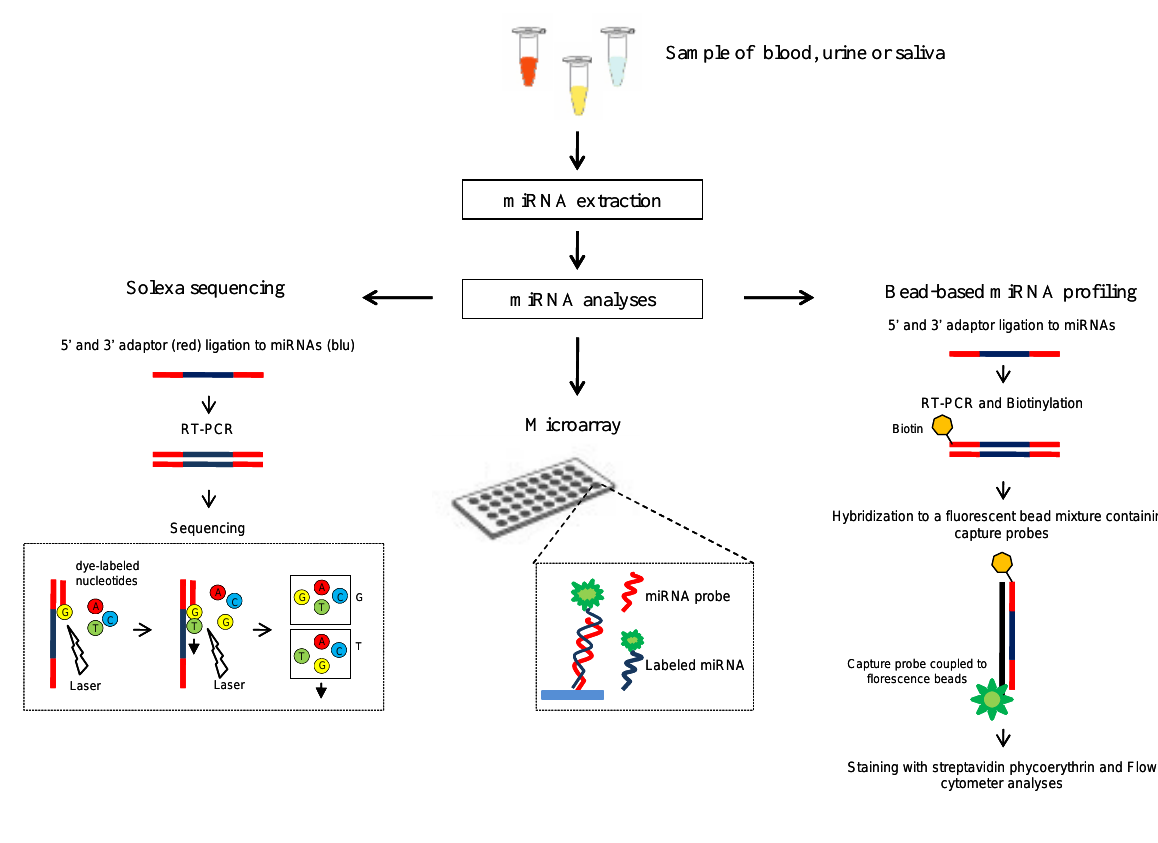
Figure 2 . Main methods used for circulating miRNA